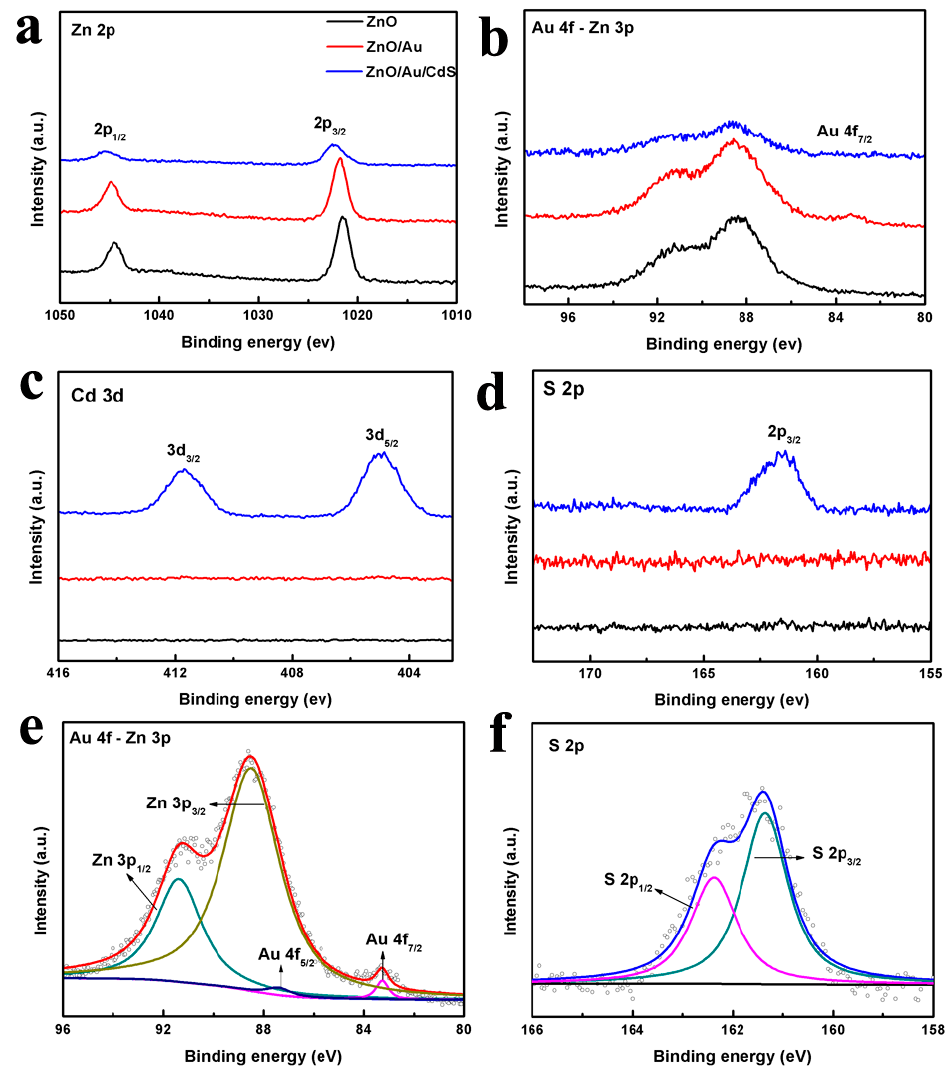
Figure 4. ( a ) Zn 2p, ( b ) Au 4f-Zn 3p, ( c ) Cd 3d, and ( d ) S 2p peaks in XPS spectra of ZnO, ZnO/Au and ZnO/Au/CdS samples, respectively; ( e ) Au 4f-Zn 3p peaks of ZnO/Au sample and ( f ) S 2p peaks of ZnO/Au/CdS sample.